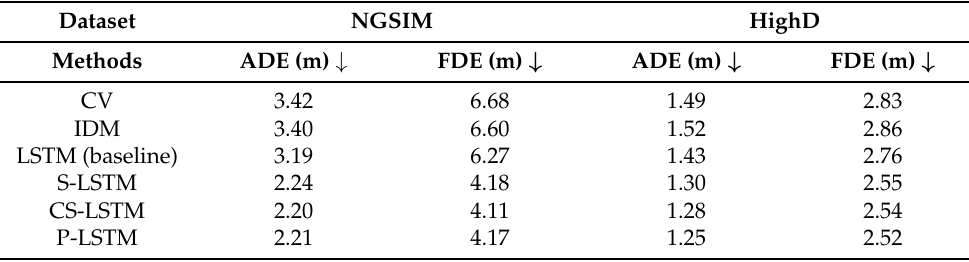
Table 1. Vehicle trajectory prediction with various interaction models on the NGSIM and HighD